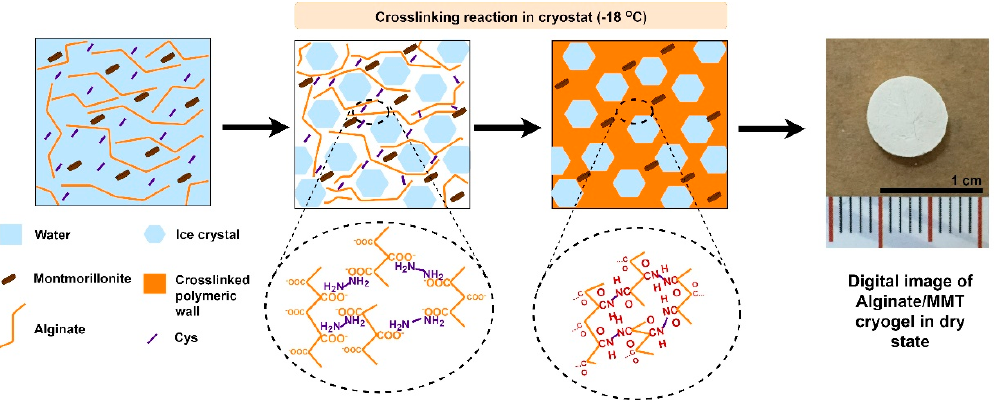
Figure 2. Schematic representation of cryogelation reaction for alginate/MMT macroporous gels and digital image of the dry gel.